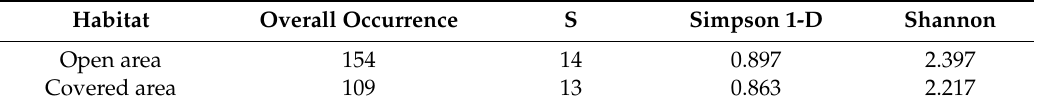
Table 9. Termites diversity index in the two habitats (S = total observed species for each habitat).